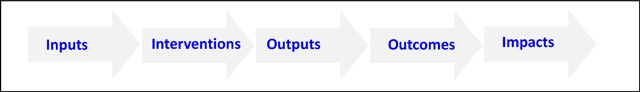
The logic model.